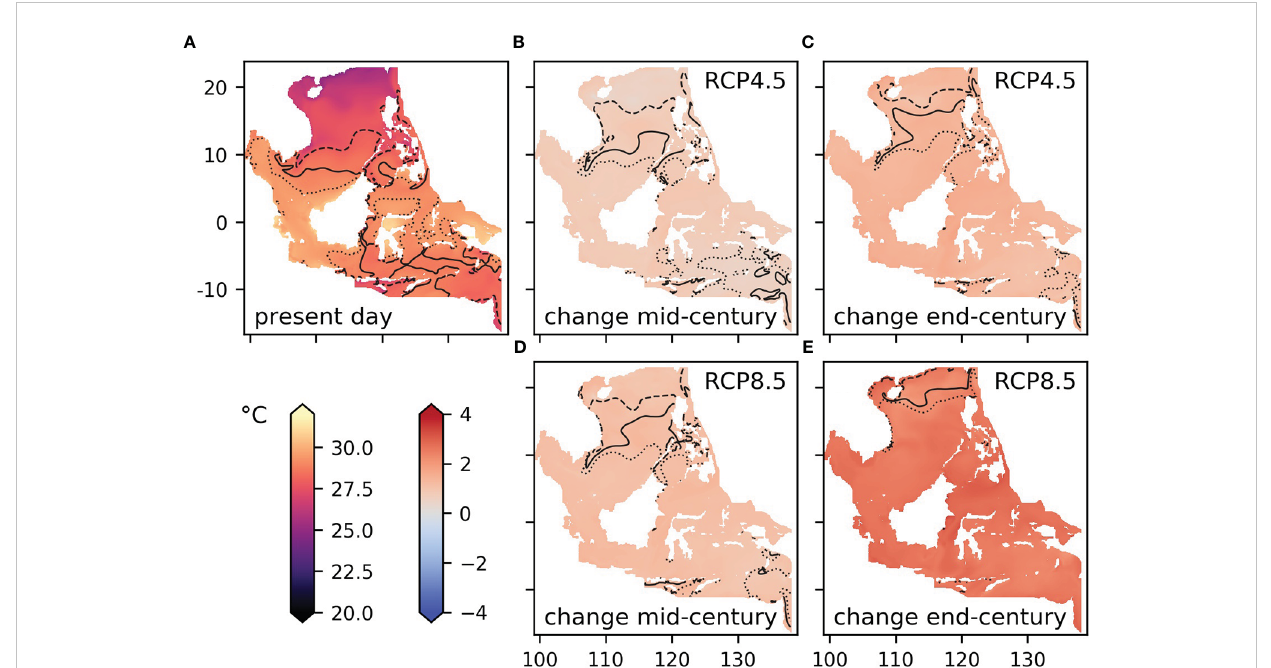
FIGURE 5 Modelled sea surface temperature: (A) mean for the present day (2000-2019), (B, D) difference between the mid-century (2040-2059) mean and the 2000-2019 mean under RCP4.5 and RCP8.5, (C, E) difference between the end-century (2079-2098) mean and the 2000-2019 mean under RCP4.5 and RCP8.5. The solid black contour shows the median temperature for the present day, the dashed line the 25th quartile and the dotted line shows the 75th